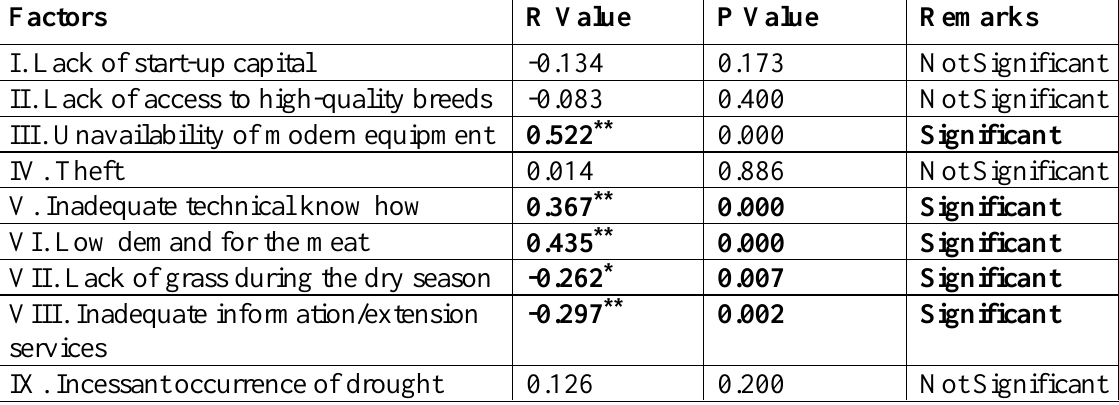
Table 5 . The Result of PPMC Analysis of the relationship between factors Affecting Small Ruminant Production and the Climate Smart Small Ruminant Production Practices